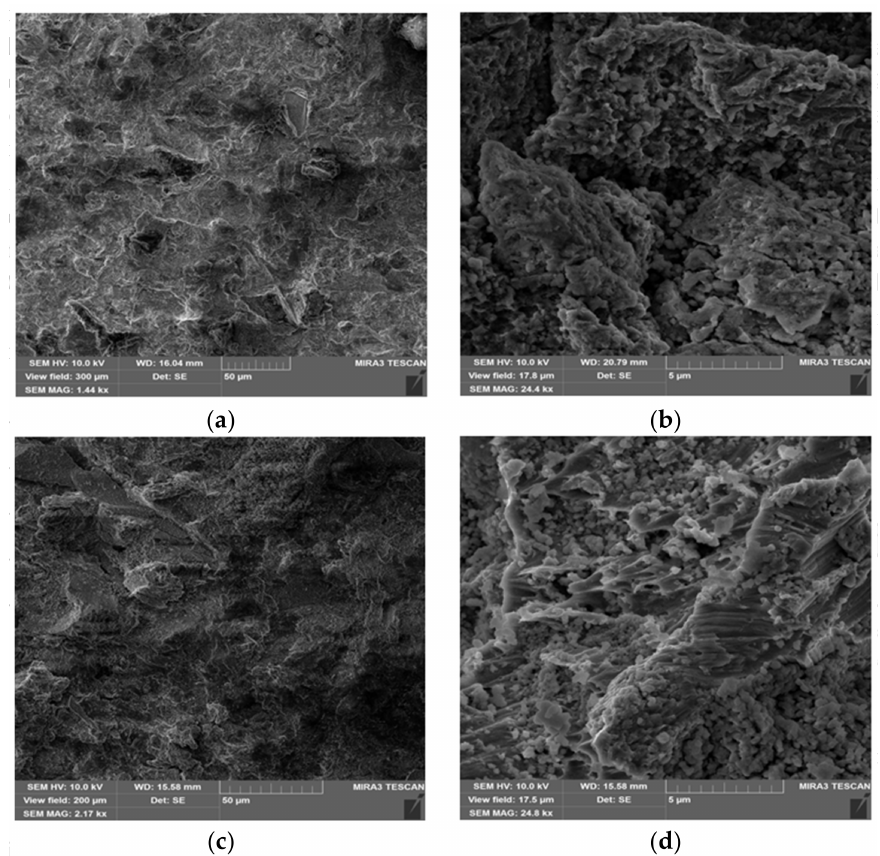
Figure 4. Scanning electron microscopy of samples after sandblasting using T–ZrO 2 powder ( a , c ) and T–ZrO 2 powder ( b , d ) in different regimen: ( a , b) —5 sec with pressure of 4 atm, ( c , d )—5 sec with pressure of 6